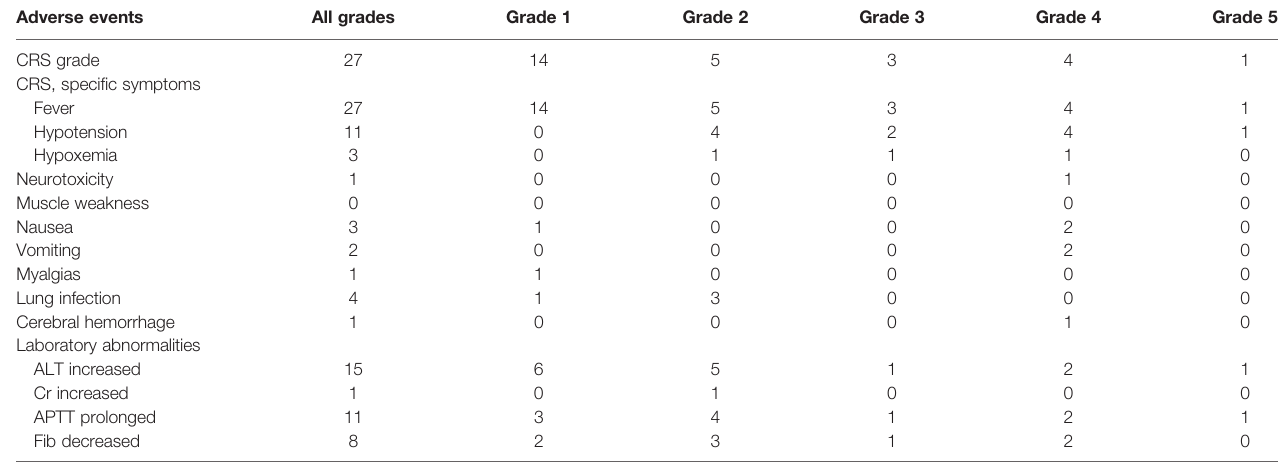
TABLE 2 | Treatment-emergent adverse events.